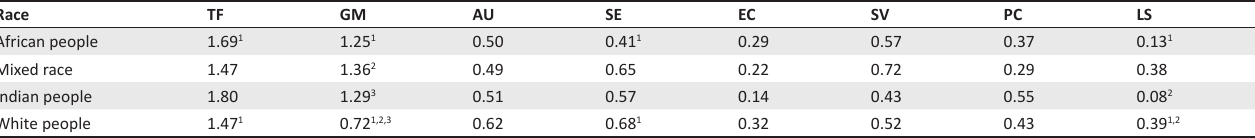
TABLE 4: Career anchors and race in the short term (1 to 3 years). Race African people